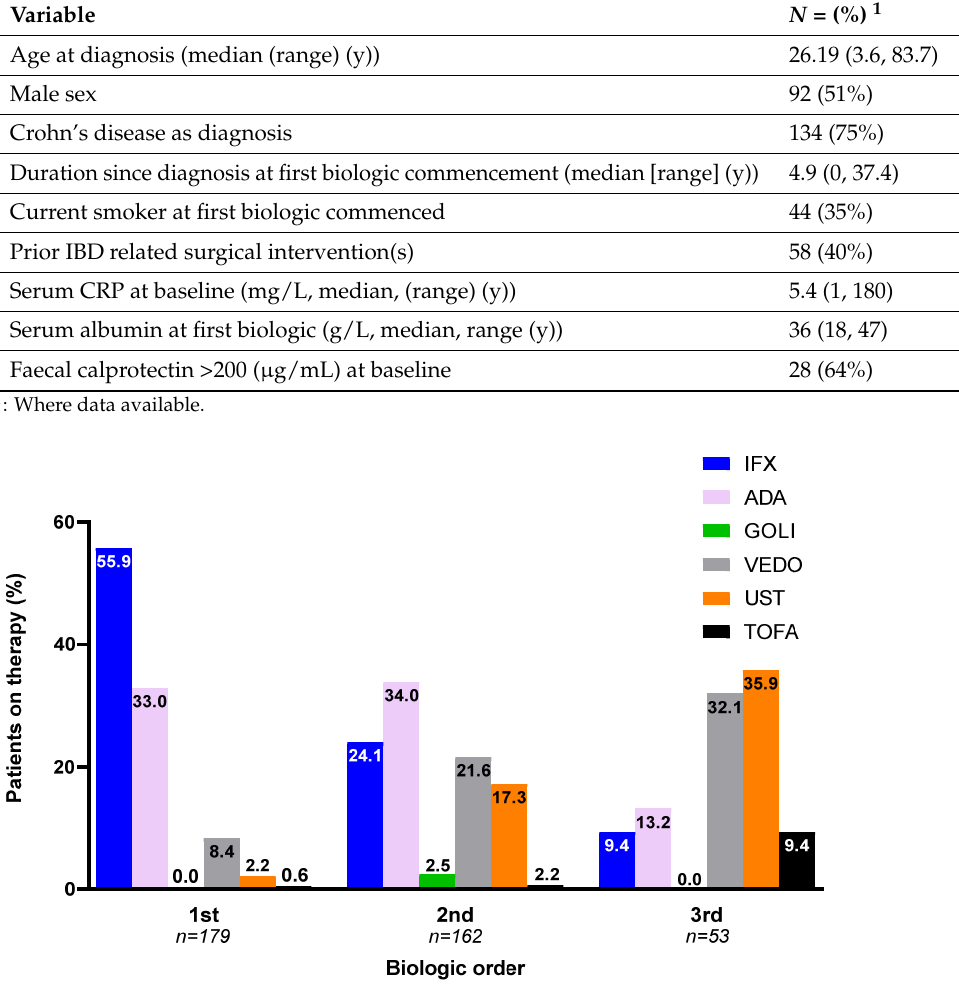
Figure 1. Order of therapy by biologic agent (proportion (%) per total number of patients on first-, second-, and third-line biologic within study follow-up period) (IFX—infliximab; ADA—adalimumab; GOLI—golimumab; VEDO—vedolizumab; UST—ustekinumab; TOFA—tofacitinib) .